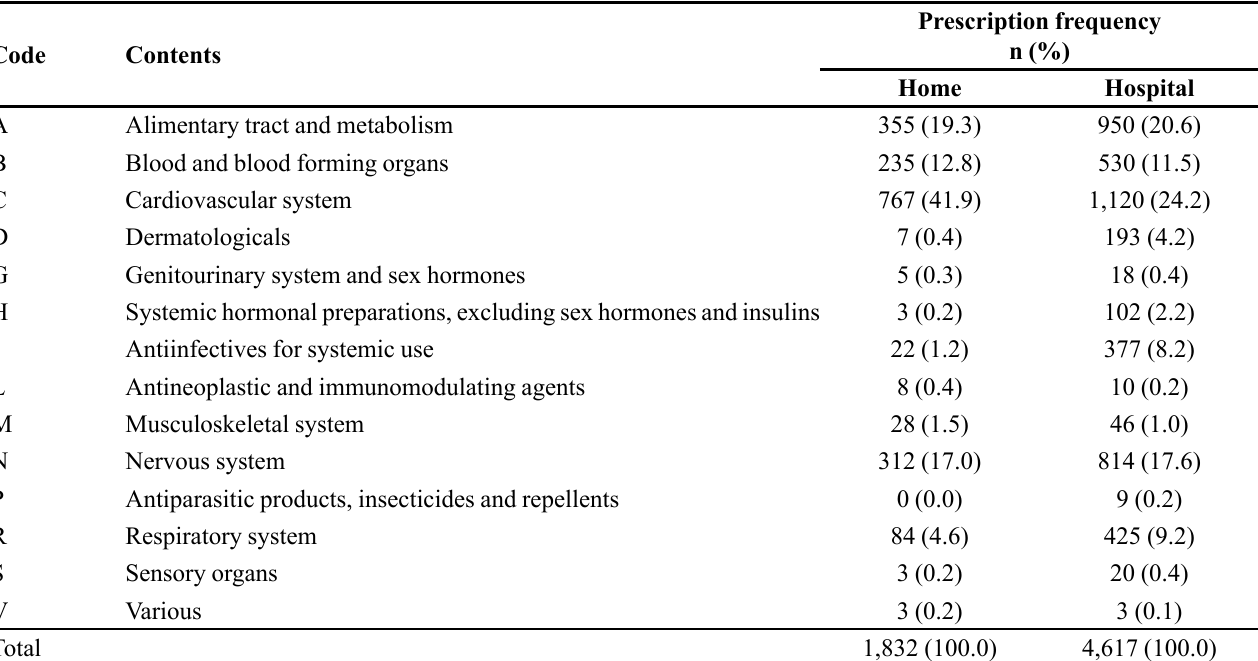
TABLE II - Distribution of the medicines taken by the surveyed elderly hospitalized, from February through September 2016, according to the ATC classification. Tubarão (SC),